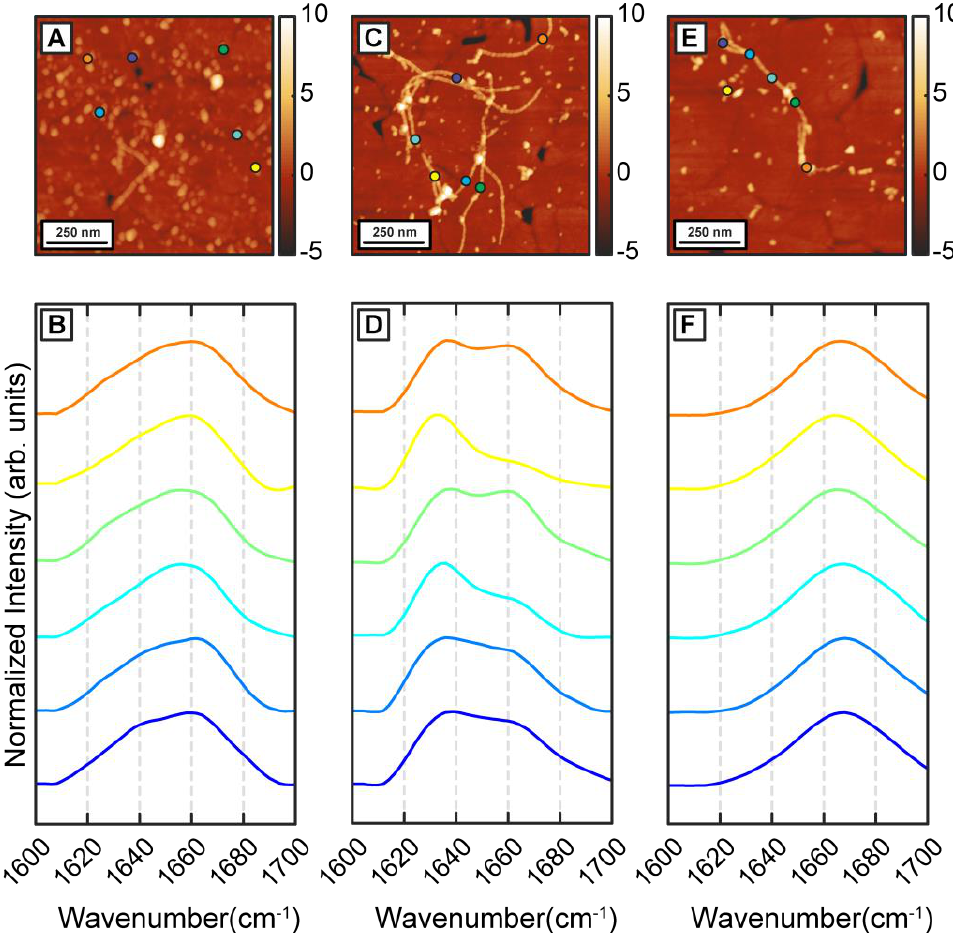
Figure 2. AFM-IR characterization of A β42 aggregates in presence of β -carotene (1:1 molar ratio) for 1 h and 6 h. ( A ) AFM topograph of Aβ42 oligomers formed after 1 h of incubation. ( B ) Representative IR spectra obtained from the oligomers. ( C ) AFM images for 6 h sample with the presence of one type of structural polymorph and ( D ) IR spectra obtained from it. ( E ) AFM topograph of other type of fibrillar structural polymorph obtained after 6 h and ( F ) representative IR spectra obtained from them. Dots on the AFM topographs show the corresponding location of IR spectra.